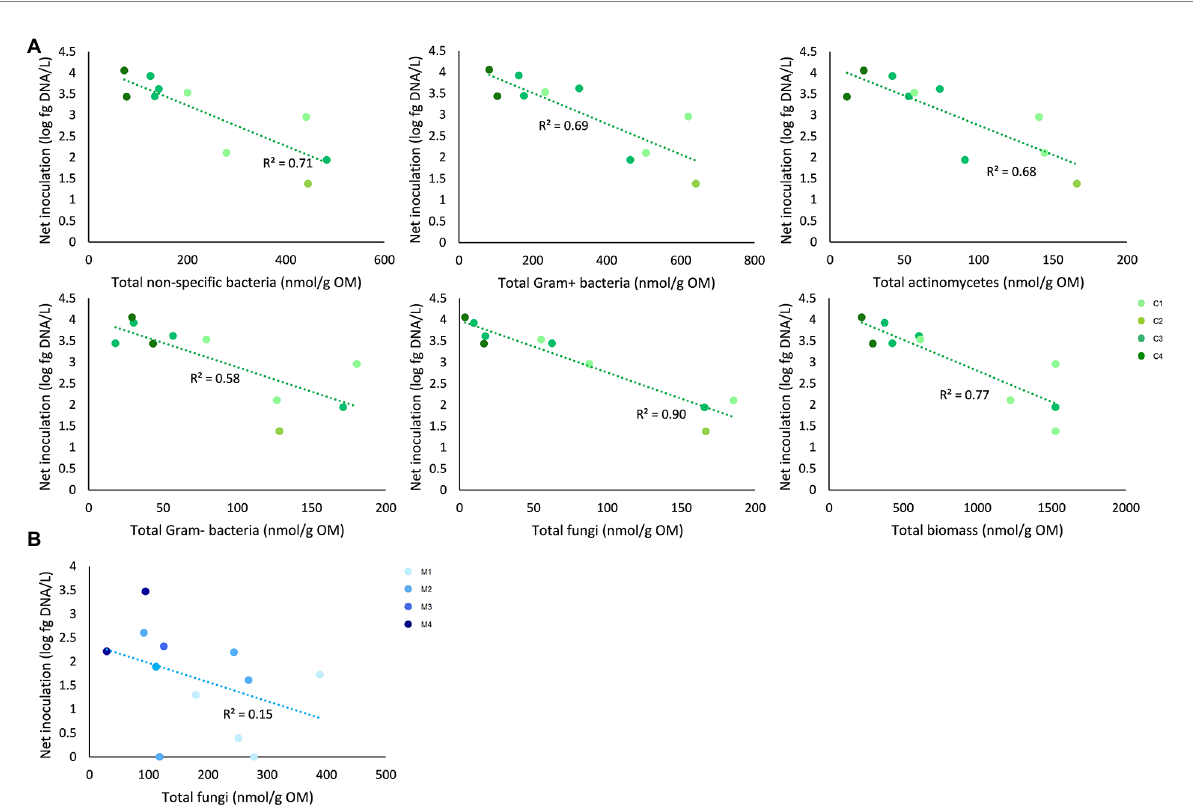
FIGURE 5 Correlations between initial microbial characteristics of composts and management residues and net inoculation of Trichoderma harzianum . (A) Net inoculation in composts was significantly correlated with the initial biomass of non-specific bacteria, Gram-positive bacteria, Actinomycetes, Gram-negative bacteria, fungi, and the total initial microbial biomass. (B) Net inoculation in management residues was significantly correlated with biomass of fungi. Determination coefficients ( R 2 ) are shown. Colors indicate the different subtypes of composts and management residues. C1 = green composts ( n = 3); C2 = VFG composts ( n = 1); C3 = woody composts ( n = 4); C4 = peat composts ( n = 2); M1 = grass clippings ( n = 4); M2 = chopped heath ( n = 4); M3 = forest sods ( n = 2); M4 = woody fractions of composts ( n =